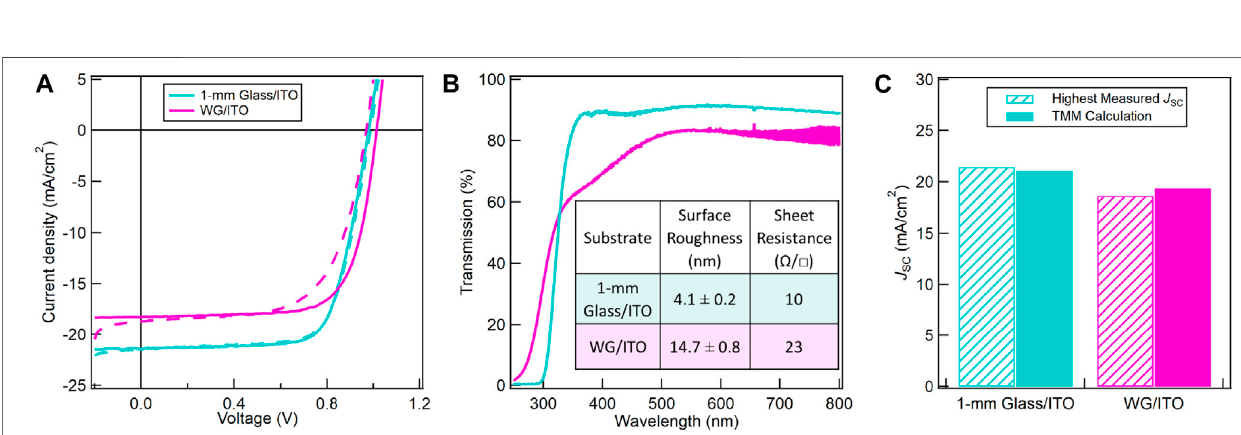
FIGURE 7 | (A) Forward (dashed) and reverse-scan (solid) J-V curves for PSCs made with TA NiO x exhibiting the highest measured J SC on either 1 mm Glass/ITO or WG/ITO. (B) UV-vis transmission spectra for 1 mm Glass/ITO and WG/ITO. The inset table shows surface roughness and sheet resistance for both substrates. The sheet resistance for 1 mm Glass/ITO is from vendor data. (C) Highest measured J SC (hashed), i.e., devices in (A) , vs. theoretical J SC calculated from TMM (solid). Cyan and magenta represent 1 mm Glass/ITO and WG/ITO,